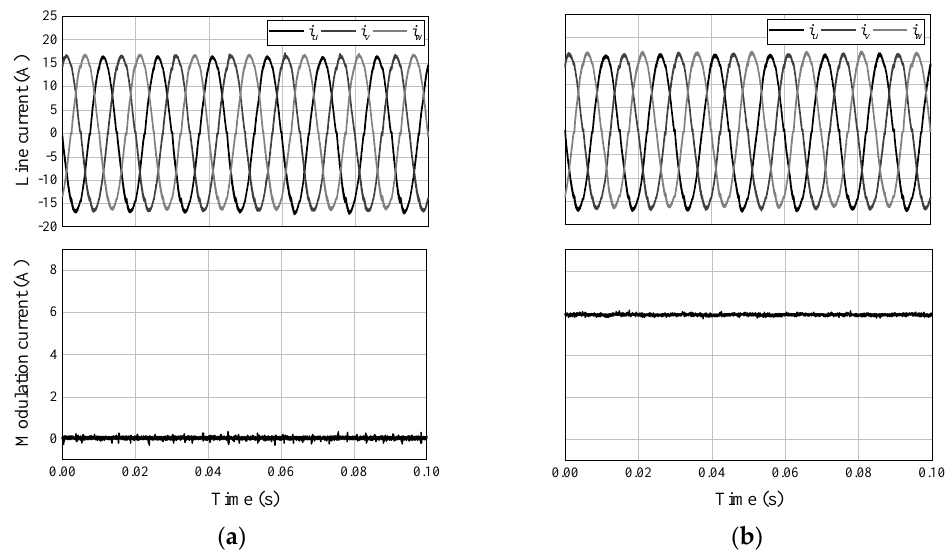
Figure 23. Experimental results of current control: ( a ) with i q of 20 A and i m of 0 A; ( b ) with i q of 20 A and i m of 6